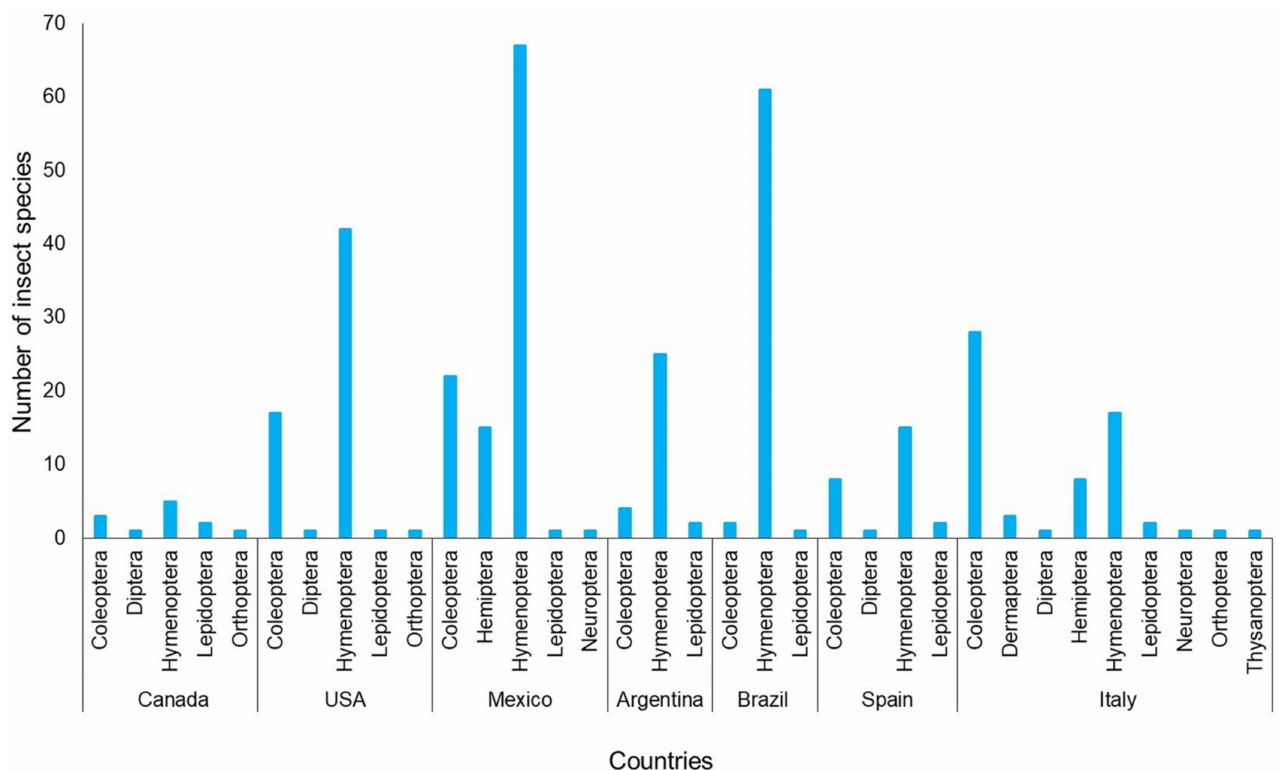
Figure 4. Number of orders of insect species associated with the flowers of Opuntia species in retrieved articles found through three academic databases between 1911 and 2020 worldwide. Further details in Table S1.